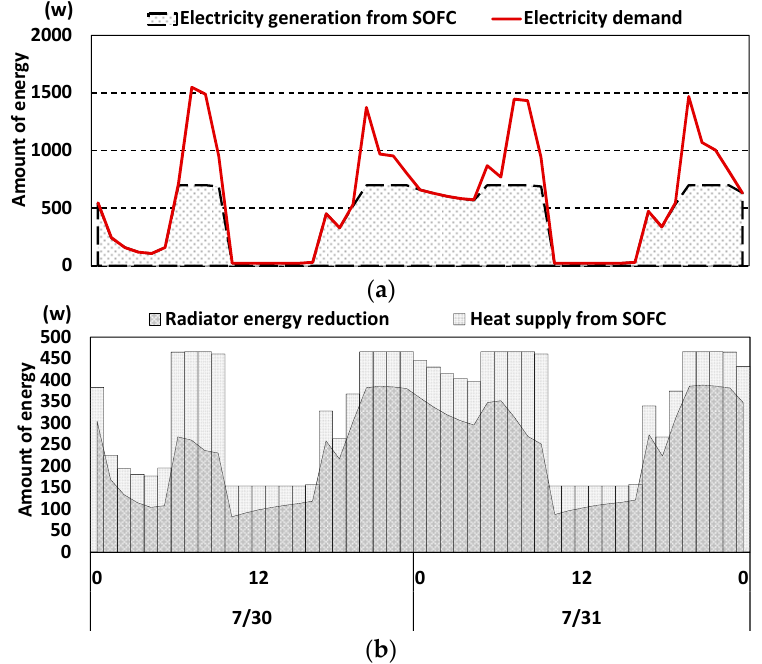
Figure 10. Hourly simulation data of household 3. ( a ) Data of electricity generation and electricity demand; ( b ) Data of heat reduction and heat supply.